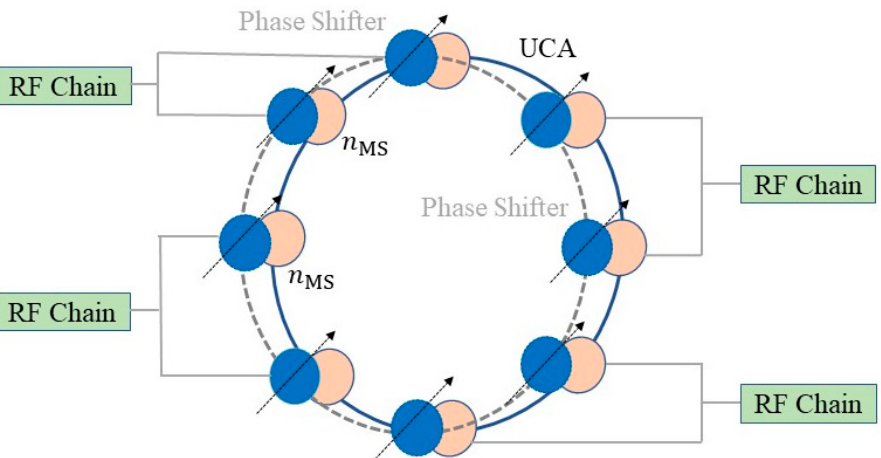
Figure 1. Hybrid beamformer at the mobile station (MS).